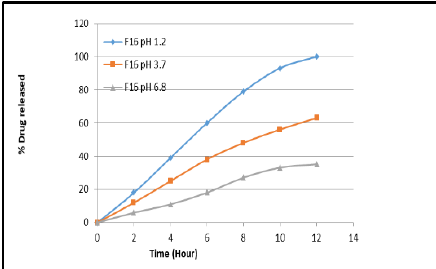
Figure 7. Release profile for pH-dependent ITZ floating microparticles at various pH.